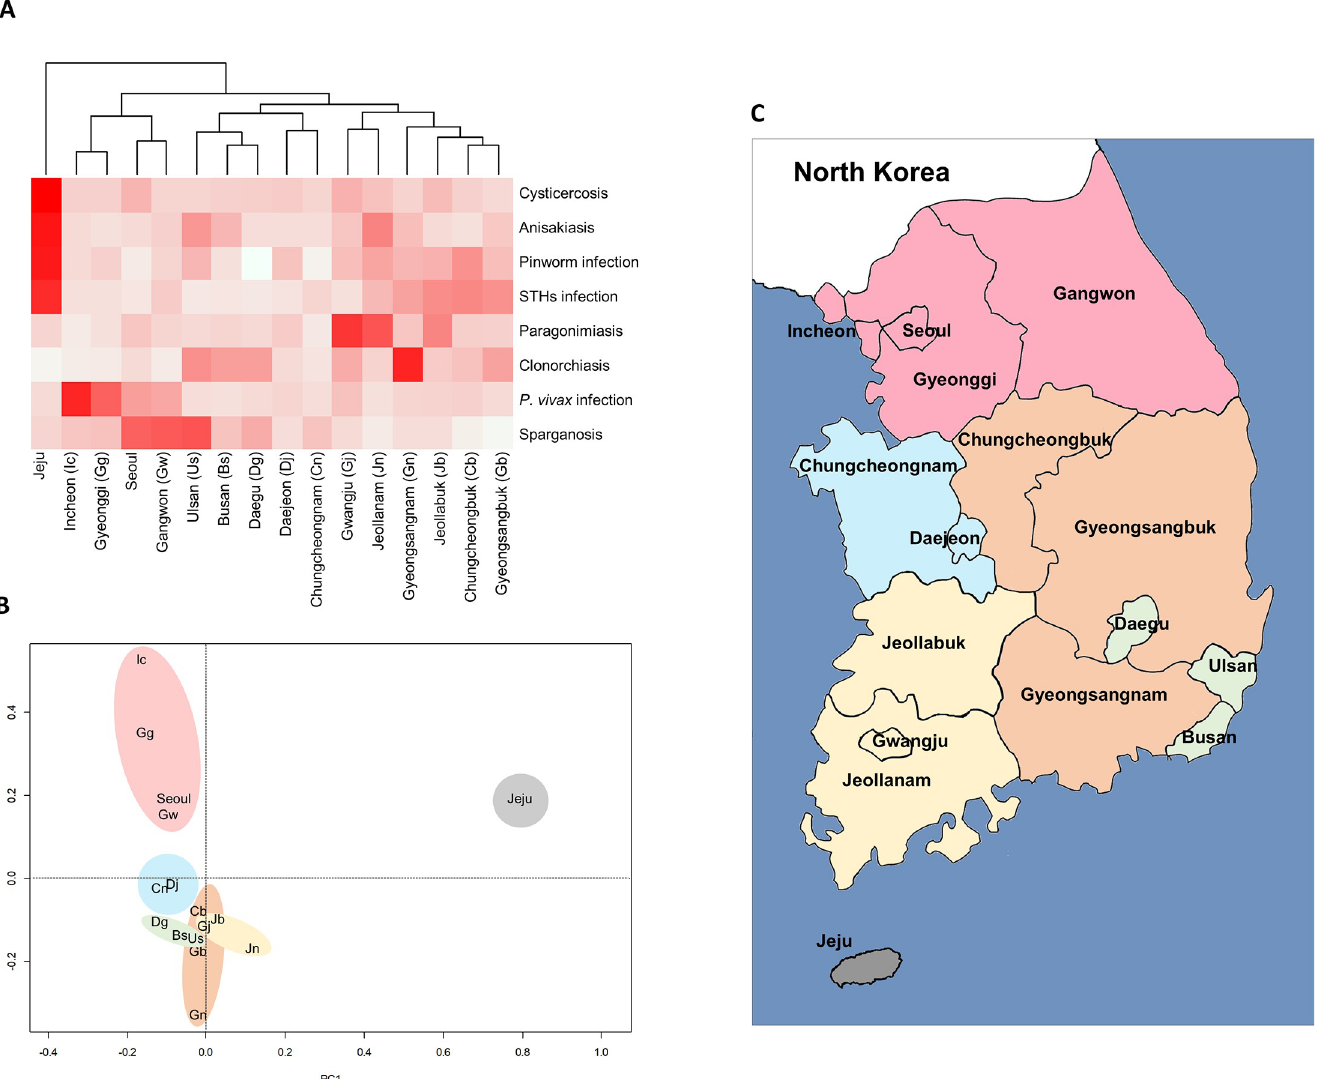
Fig 2. Claims frequency of endemic parasitic infections by province in South Korea. (A) Heatmap and dendrogram for the claims frequency of each parasite infection by province. Columns indicate the hierarchical clustering of the provinces that have a common pattern of claims frequency regarding parasite infection. (B) Principal component analysis (PCA) revealed claims frequency of parasitic infections by province. PCA showed that some provinces have similar parasitic infection patterns. (C) Map of South Korea representing patterns of endemic parasite infections analysed using the Heatmap (A) and PCA (B) data. Provinces with similar parasite infection patterns appear in the same color. The outline of the map of South Korea was manually drawn, and the map was colored using Microsoft Paint according to the relevant